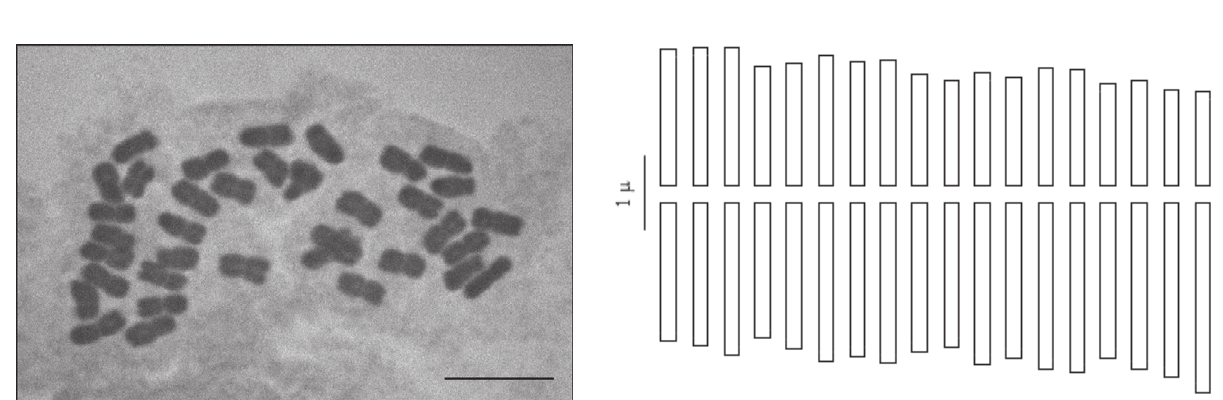
Figure 2. Somatic metaphase in A. taurica (2 n= 36), and haploid idiogram (Scale bars: 1